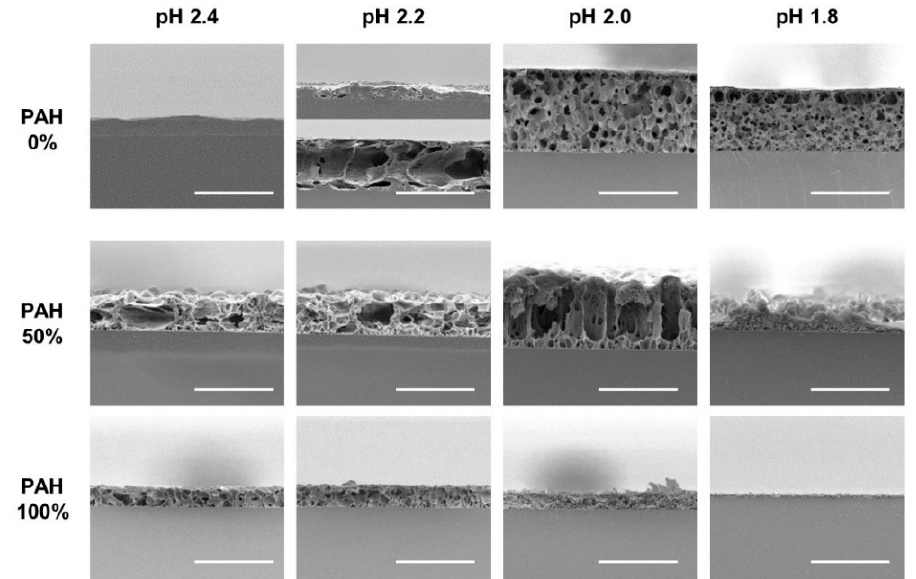
Figure 6. Cross-sectional SEM images of LbL films assembled with the 0%, 50%, and 100% PAH ratio treated at different pH values. Two regions with different structures were observed for the film assembled with 0% PAH ratio treated at pH 2.2 (The 2nd image in the first row). The scale bars are 20 µ